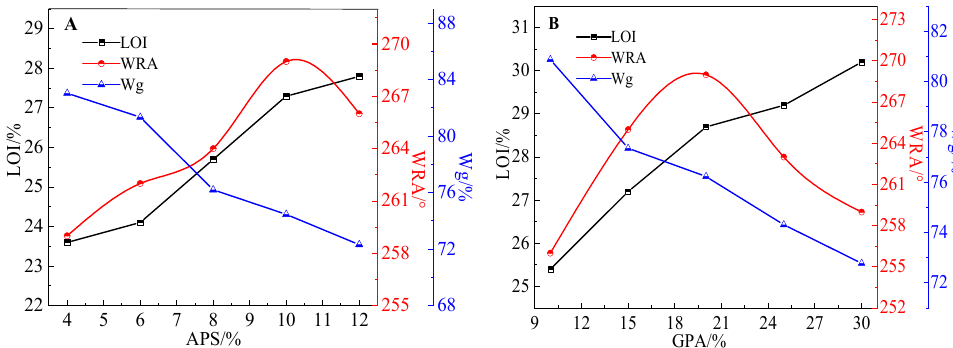
Figure 3. Effect of APS ( A ) and GPA ( B ) contents on fabrics.